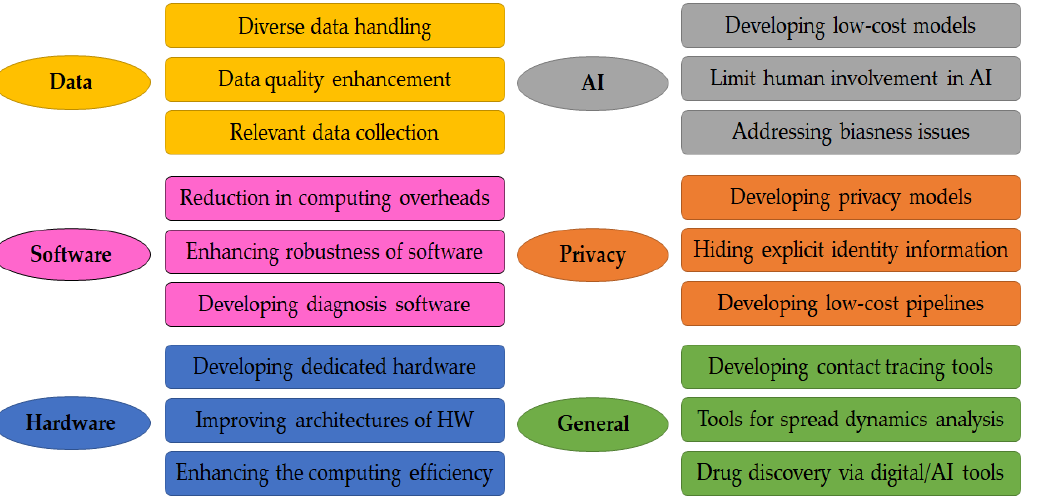
Figure 18. Overview of major challanges and future directions in the context of